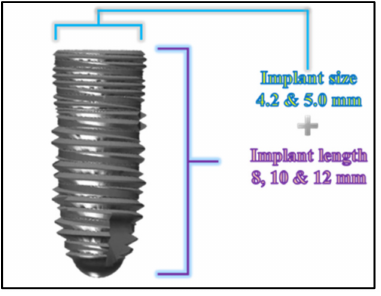
Figure 4. NOVEM dental implant